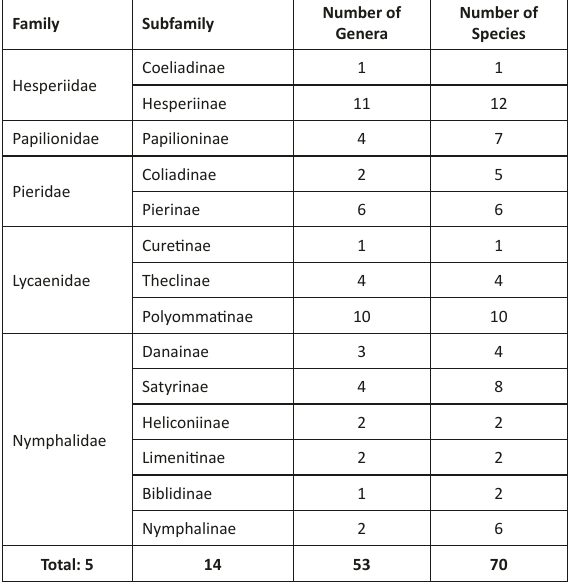
Table 1. Subfamily wise diversity of the butterflies of RRS, Chinsurah and adjoining